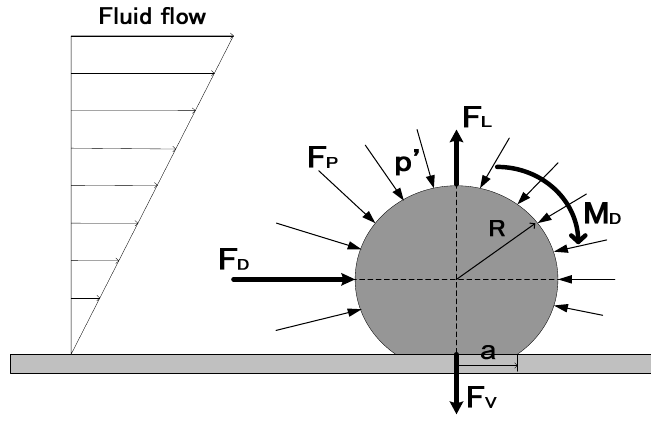
: viscous drag, F D